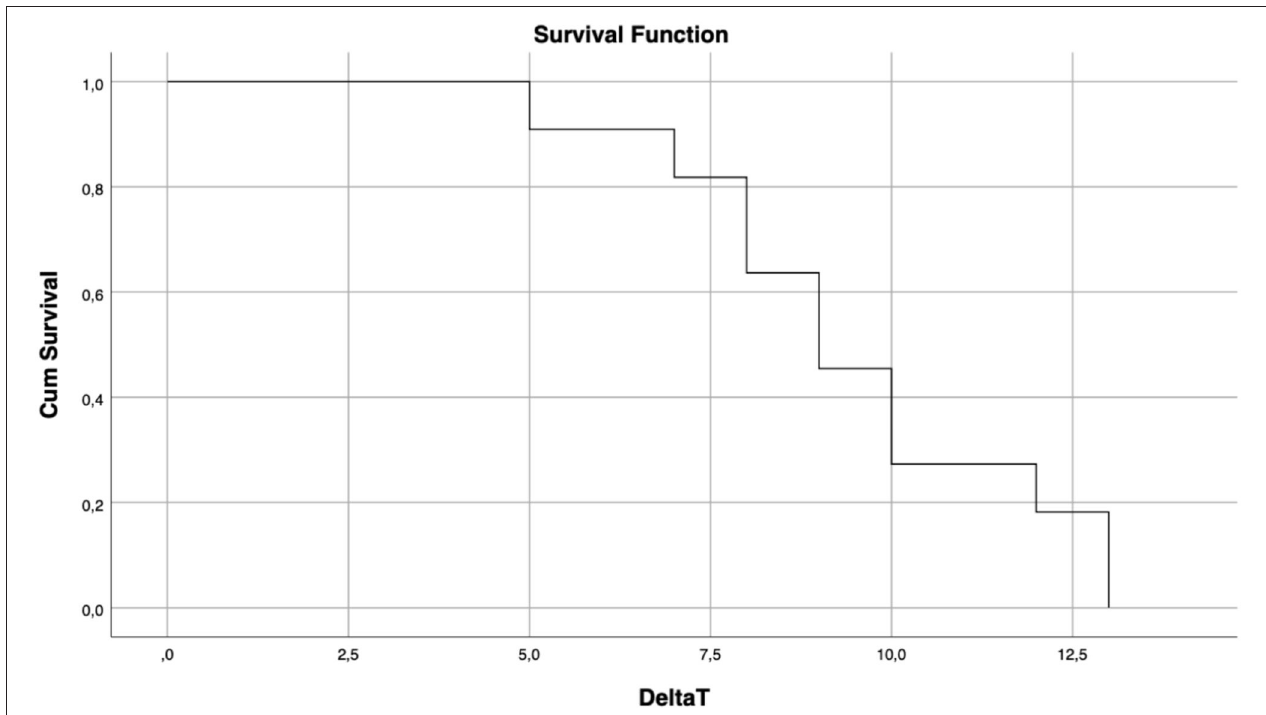
FIGURE 1 | Overall survival rate. Mean follow-up: 68 ± 28 months.